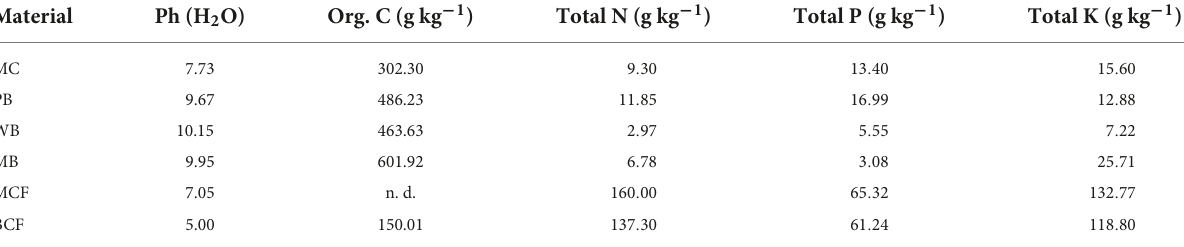
TABLE 1 Basic properties of amendment materials and fertilizer used in the experiment.